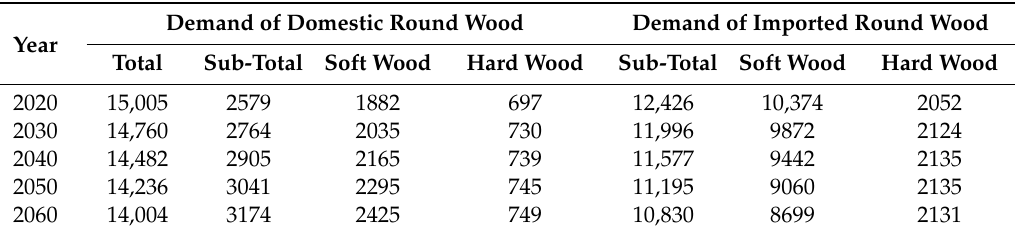
Table 8. Projected demand of round wood to produce timber products.